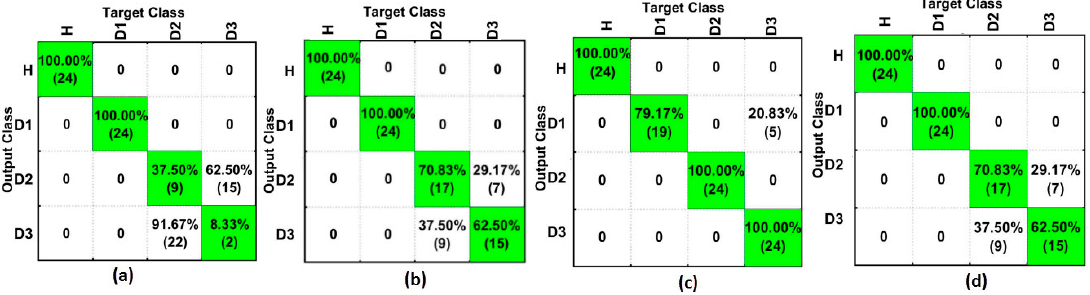
Figure 9. Results for PZT#1 and SFAN (time domain) applied to: ( a ) Euclidean Distance (ED) [35]; ( b ) Savitzky-Golay (SG); ( c ) SG + First Derivative (SGFD); and, ( d ) SG + Second Derivative (SGSD).